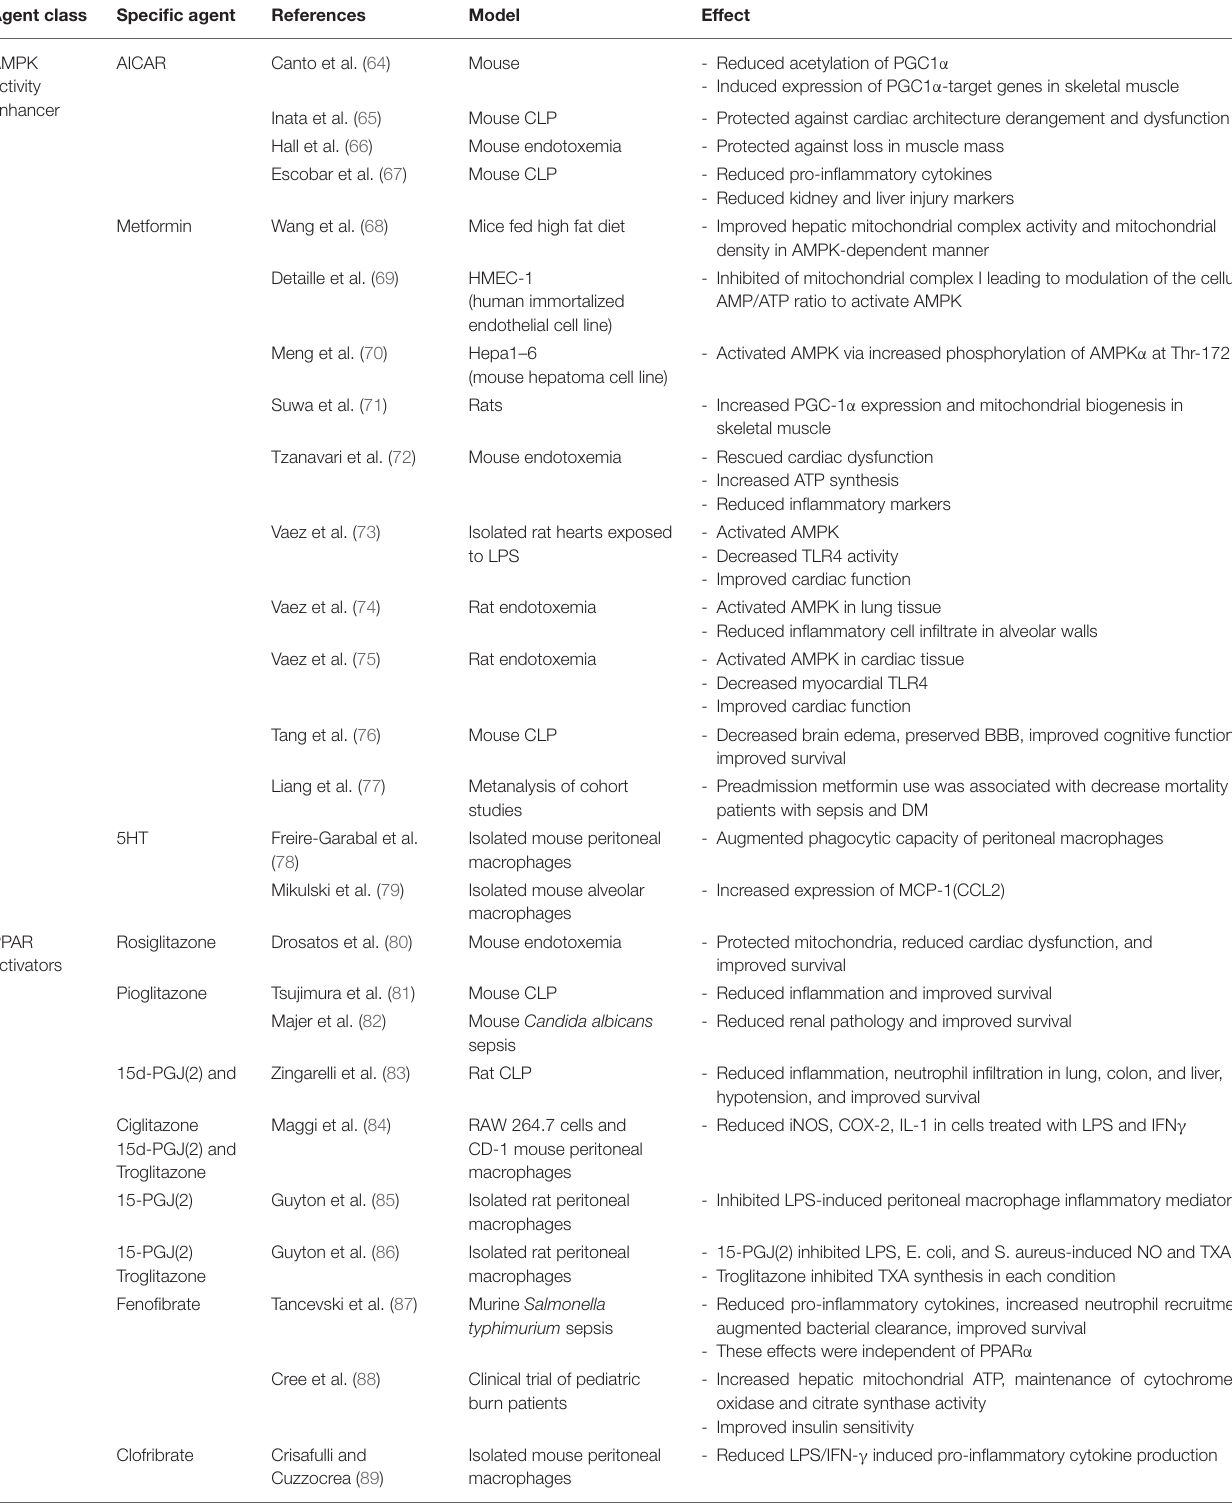
TABLE 2 | Pharmacologic agents targeting mitochondrial biogenesis and function. Agent